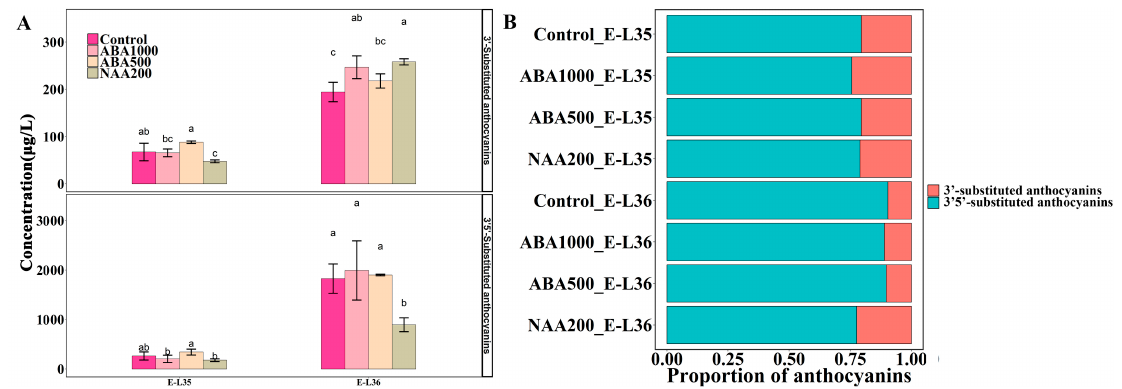
Figure 8. Changes in the concentrations of total anthocyanins, total norisoprenoids, total C6/C9 compounds, and total terpenes in the different treatments. Different letters indicate significant differences ( p = 0.05).